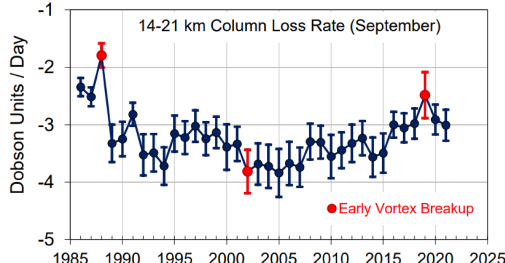
Figure 5. Linear loss rates (DUd − 1 ) within the 14–21km column during 1–30 September. The yearly data include 1 σ uncertainty bars. The loss rates calculated for the three anomalous vortex years, shown as red dots, do not include any measurements after the vortex disruption was observed in middle to late